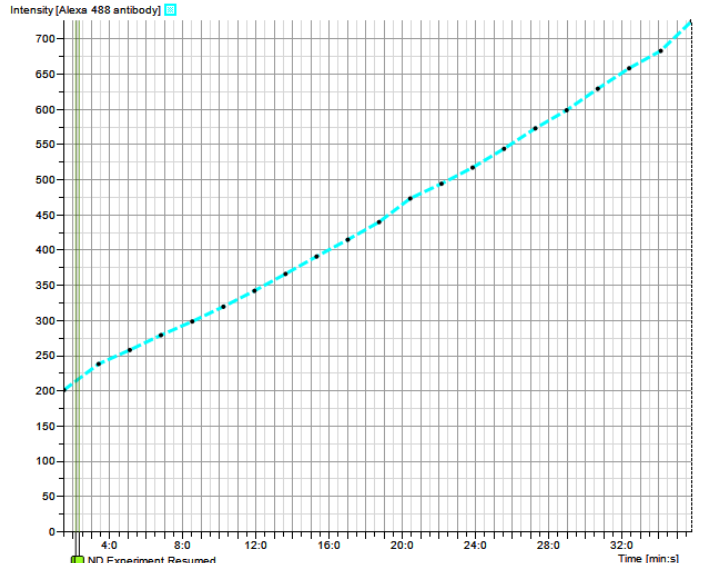
Figure 10. Imaging of 4T1 cells after 1 min ( A – D ) and 30 min ( E – H ) of incubation with PLGA-Cy5.5/Rh123 NPs. A,E— merged images and differential interference contrast (DIC); ( B , F , J )—rhodamine 123 fluorescence; ( C , G , K )—PLGA-Cy5.5 fluoresce; images ( I , L ) represent rhodamine 123 fluorescence intensity in the regions of mitochondrial fluorescence intensity (thresholding by mitochondrial fluorescence intensity of the images ( E – H ) was applied); ( M )—Dynamic of rhodamine 123 accumulation within the mitochondria (ROIs are selected based on mitotracker fluorescence intensity—artificial blue channel ( I , L )); 0–30 min of incubation. Laser scanning confocal microscopy (Nikon A1 NP). Scale bar 20 μm.